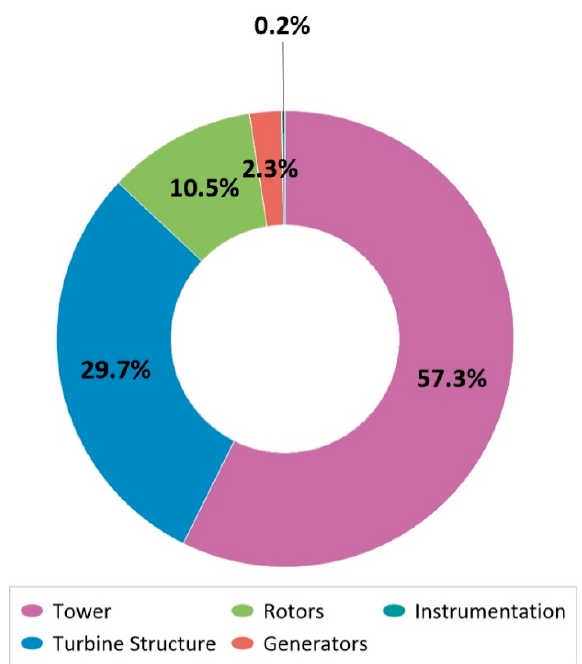
Figure 1. Mass participation of structure components of innovative wind farm.